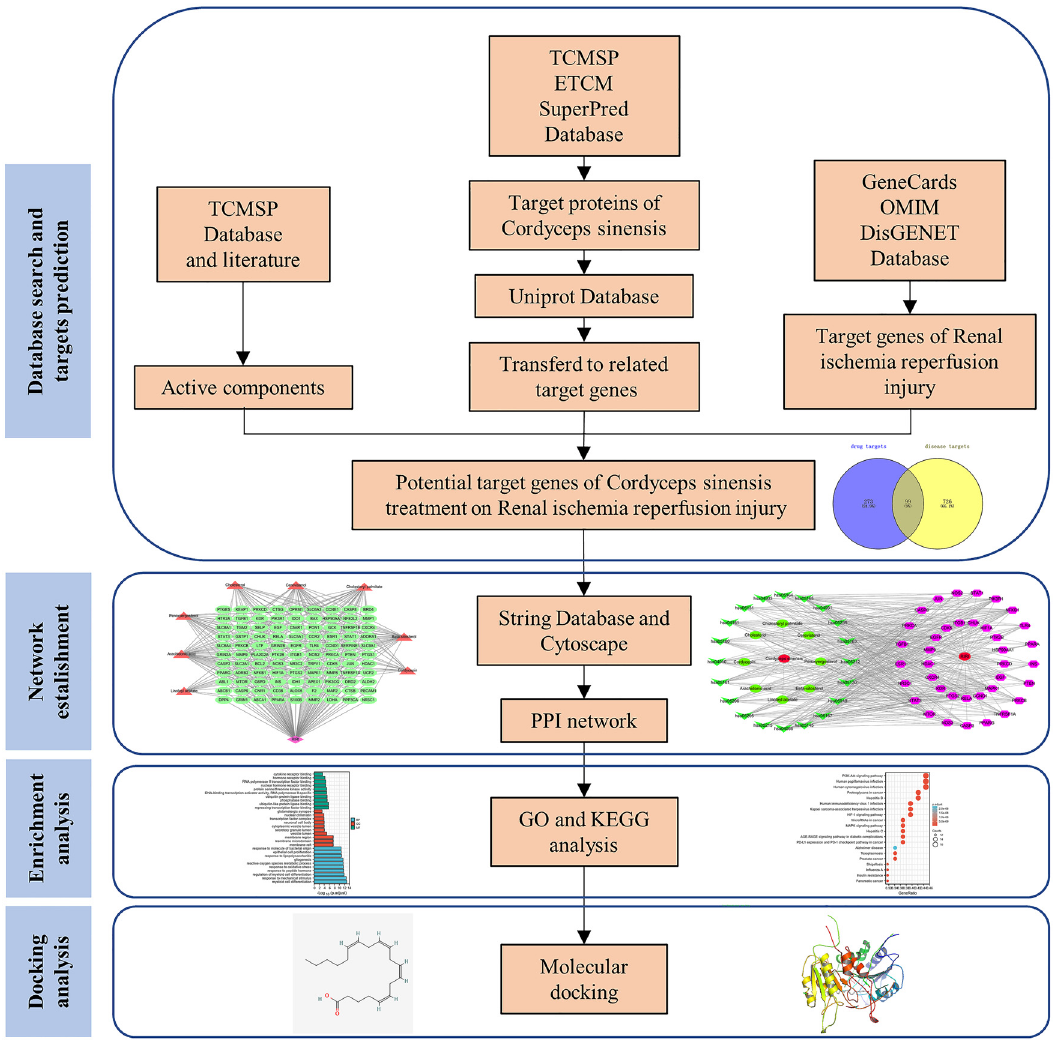
Figure 1: The work fl ow of this